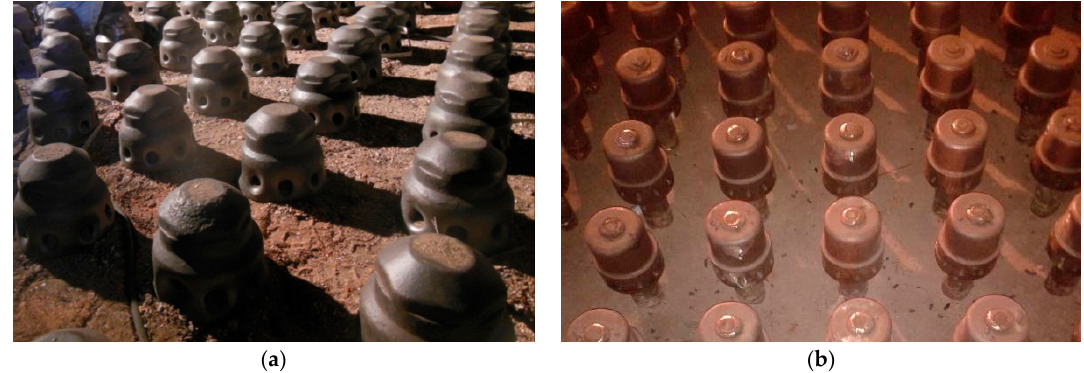
Figure 15. Air nozzle arrangement before and after transformation. ( a ) before transformation (nozzle A); ( b ) after transformation (nozzle B).